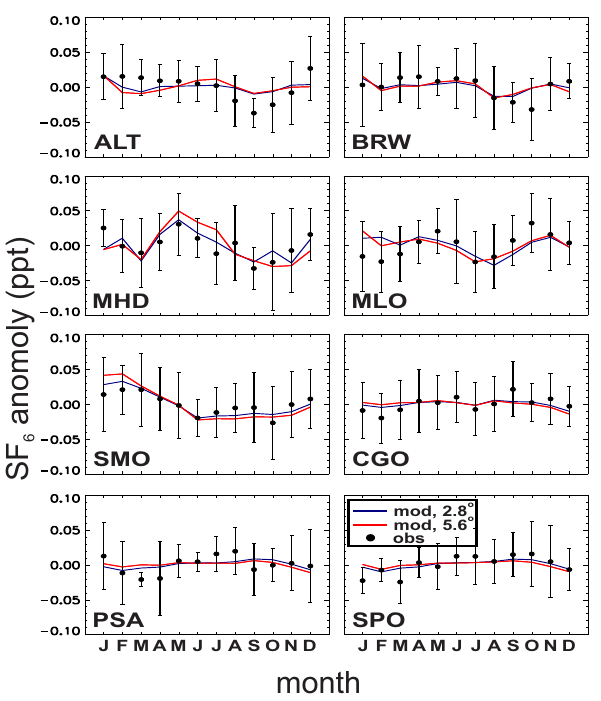
Figure 2. Modelled and observed monthly mean SF 6 anomaly (ppt) averaged over the period 2005–2010. The blue line represents modelled SF 6 using the 2 . 8 ◦ × 2 . 8 ◦ TOMCAT model grid, while the red line shows results for the 5 . 6 ◦ × 5 . 6 ◦ model grid. Black dots represent flask observations from NOAA surface station sites, and error bars show one standard deviation of the monthly mean of the observations over the six-year period.